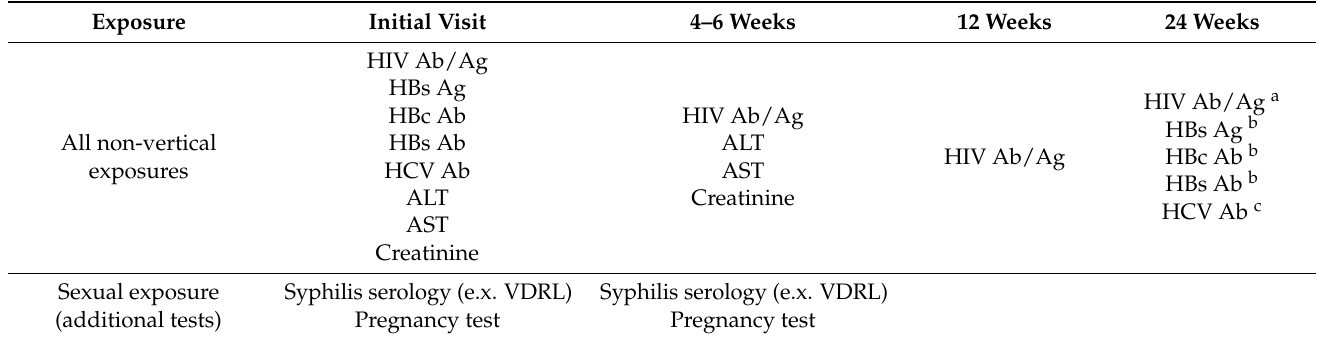
Table 5. Schedule of follow-up visits according to CDC guidelines